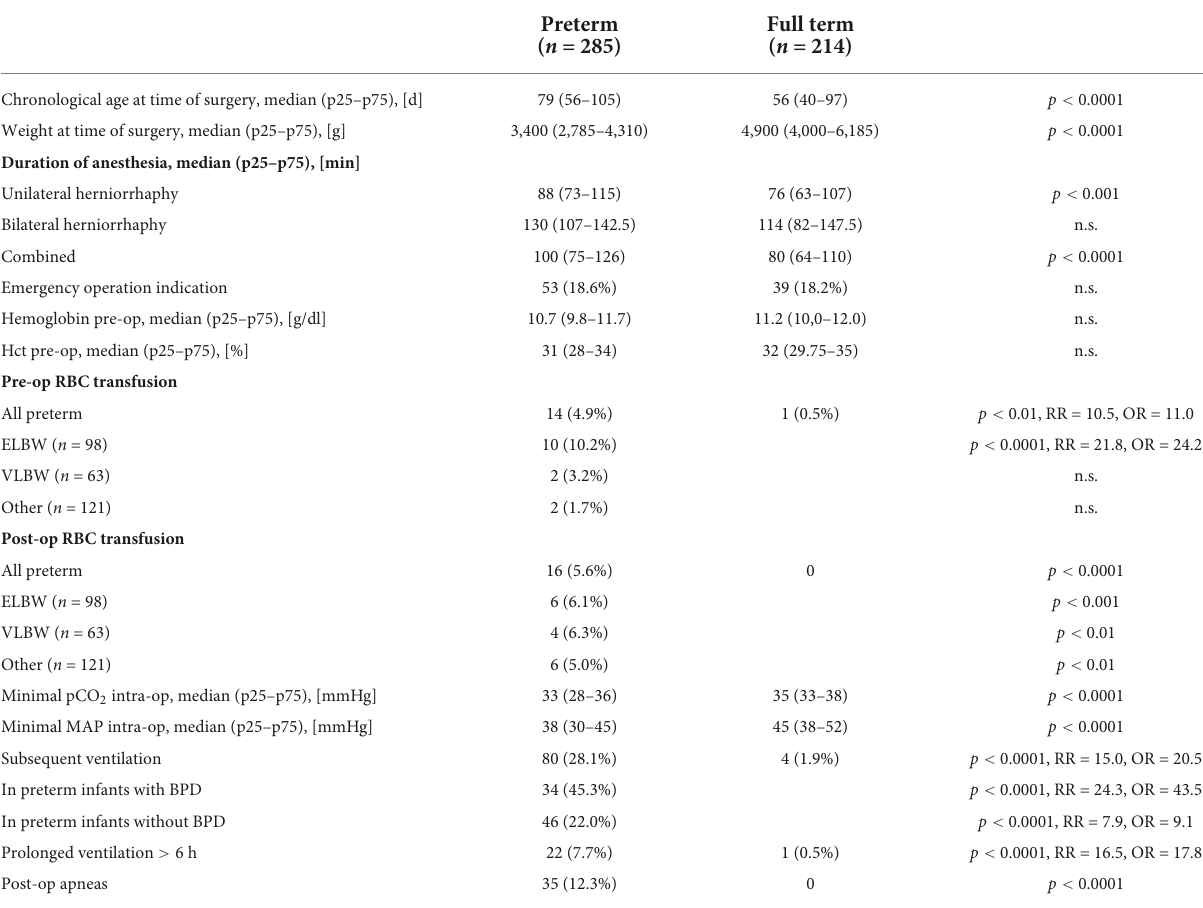
TABLE 2 Perioperative characteristics of the cohort.